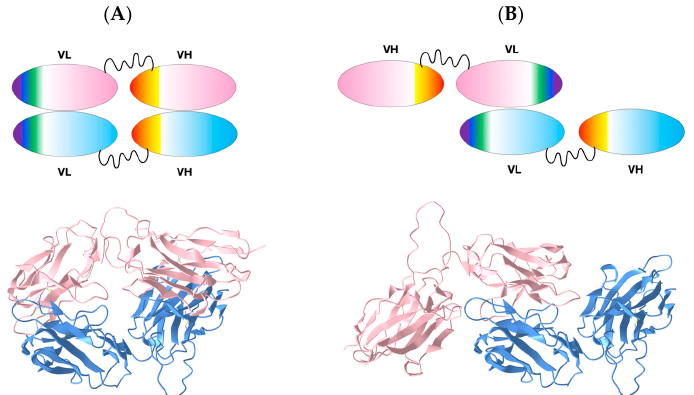
Figure 5. Comparison of VL-VL based scFv dimer. ( A ) VL-VL diabody : a canonical VL-VL dimer interface leads to a pairing of VH domains. Top: Cartoon, Bo tt om: AlphaFold2-predicted structure. ( B ) Inverted VL-VL diabody model leading to free VH domains. Top: Cartoon, Bo tt om: structural model built on the basis of the observed inverted VL-VL structure. Blue and pink coloring identi fi es di ff erent scFv domains. Models are available as supplemental data (Supplement File S4). 3D models comparison link: h tt ps://www.ncbi.nlm.nih.gov/Struc- ture/icn3d/full.html?type=icn3dpng&url=h tt ps://zenodo.org/api/ fi les/4c8a1713-cd80-4ee5-9e3c- 93782c4b3193/VLVLDIAB_VLINVDIAB_icn3d_loadable.png, accessed on 19 April 2023) .